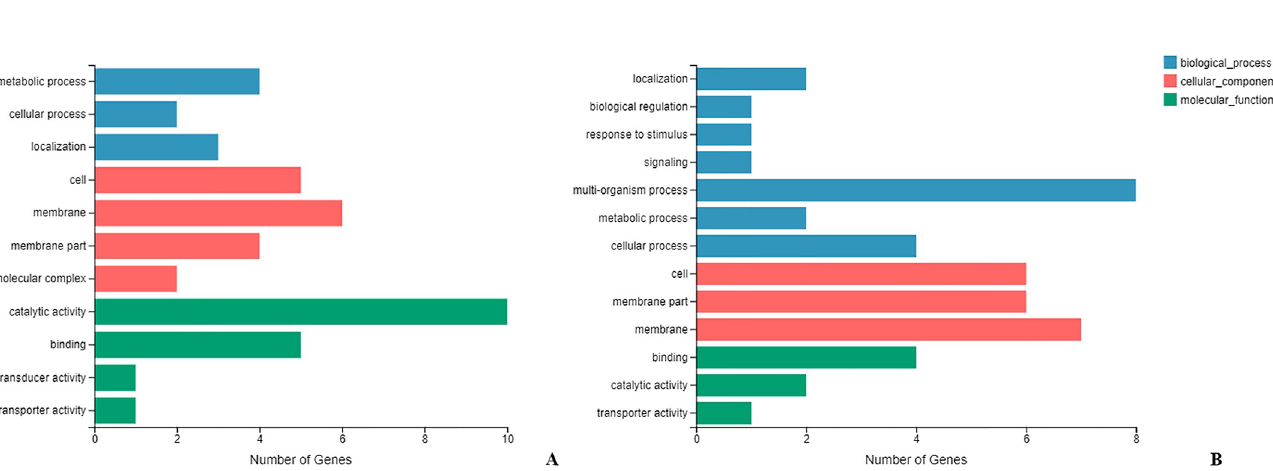
PLOS NeglectedTropical Diseases | https://doi.org/10.1371/journal.pntd.0008888 December29,